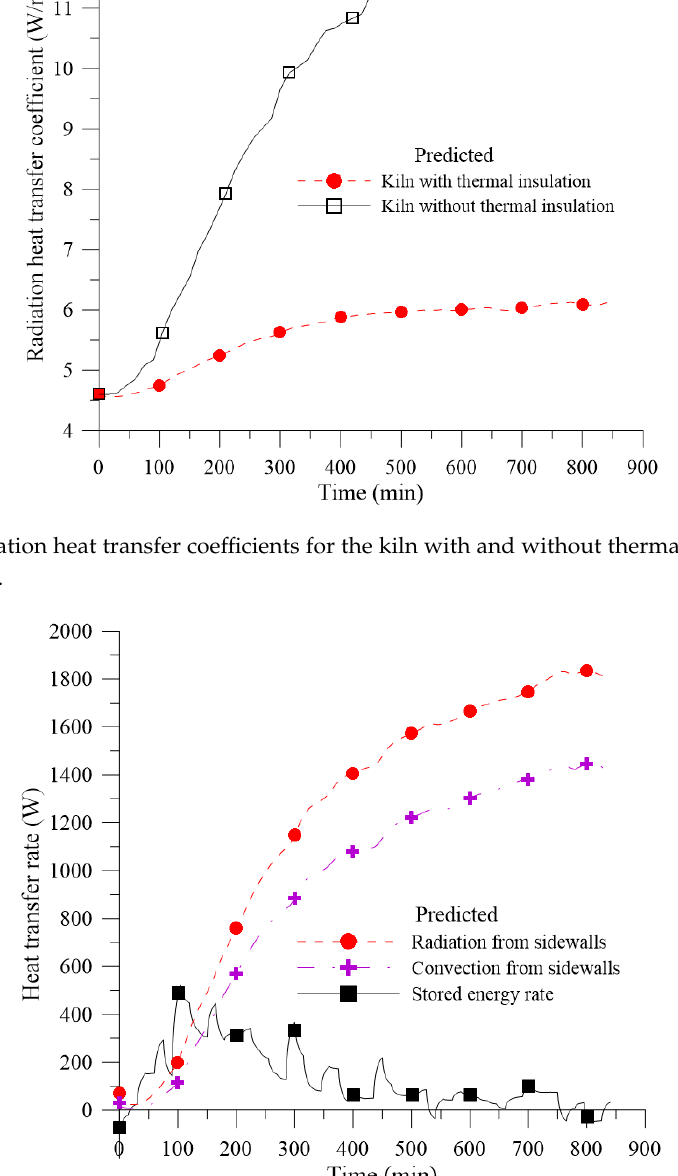
Figure 25. Heat transfer rates in the thermal insulation as a function of time.